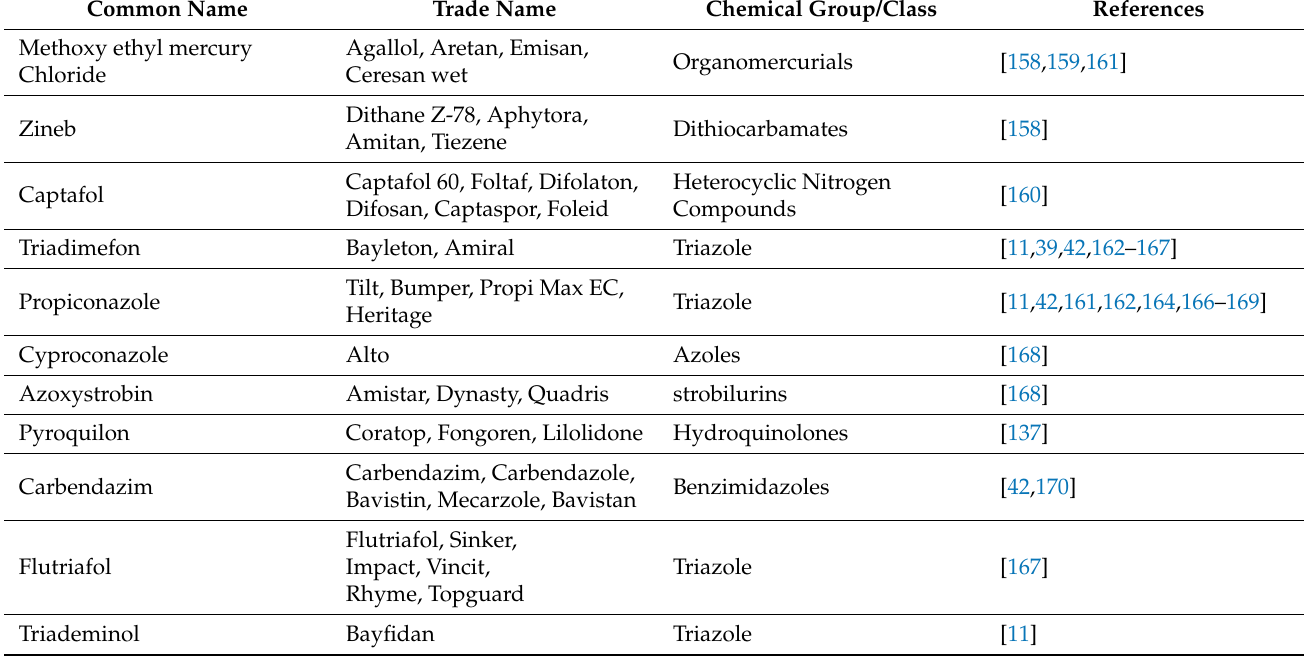
Table 1. Fungicides effective against whip smut